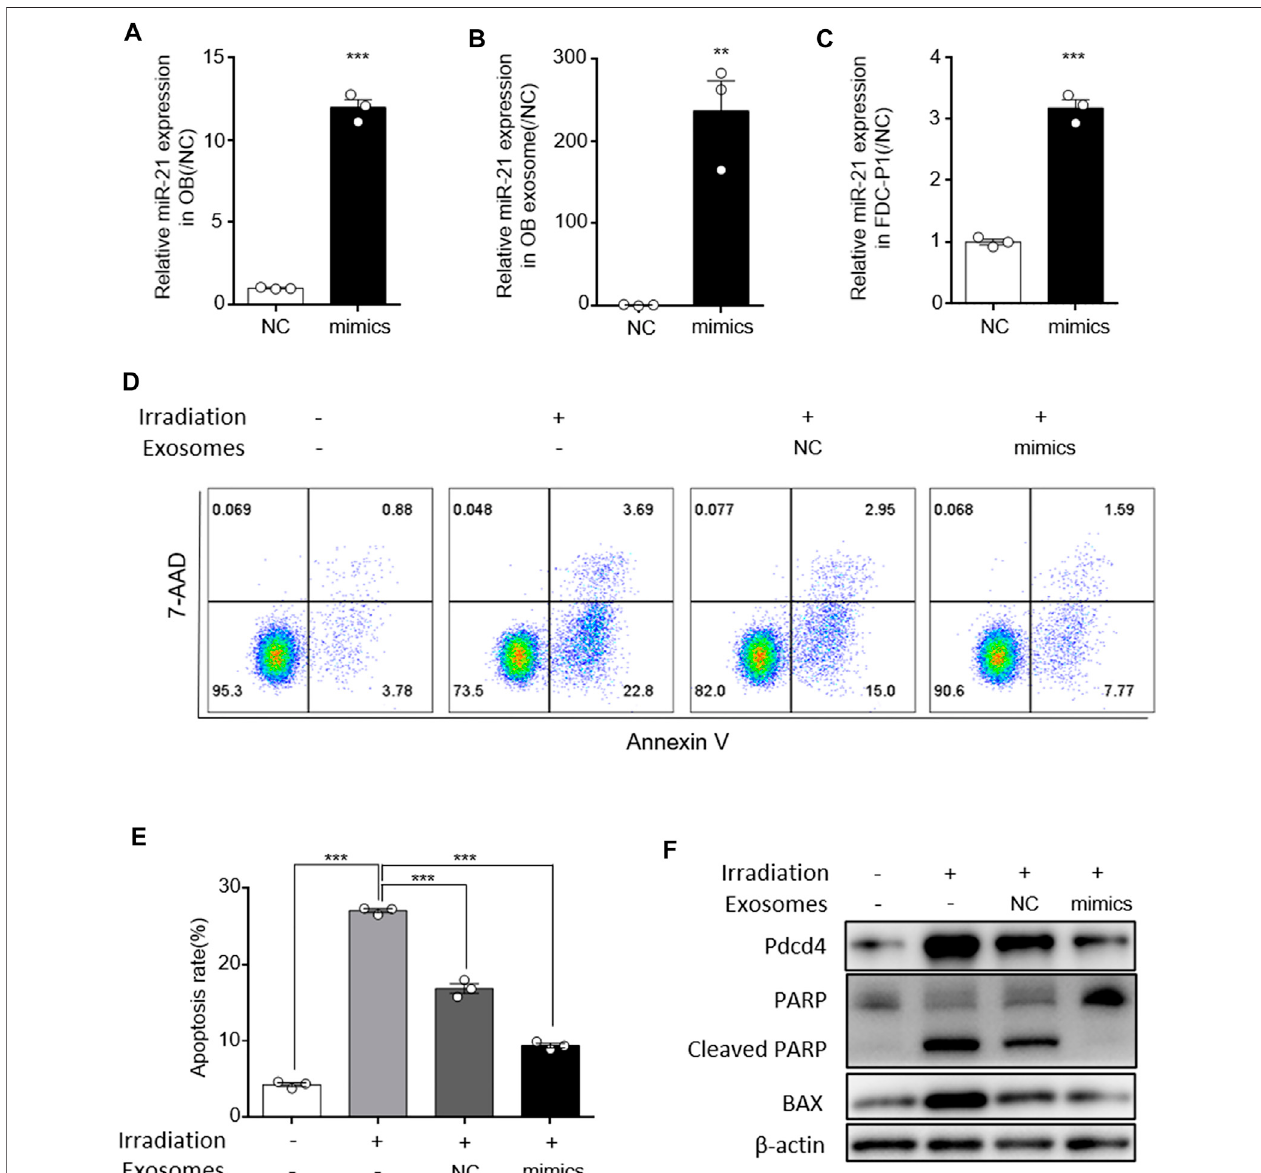
FIGURE 5 | MiR-21 in osteoblast derived exosomes alleviated irradiation induced FDC-P1 apoptosis. (A) qRT-PCR analysis of expression of miR-21 levels in osteoblast transfected with NC or miR-21 mimics. (B) qRT-PCR analysis of expression of miR-21 levels in OB-exosomes transfected with NC or miR-21 mimics. (C) qRT-PCR analysis of expression of miR-21 levels in FDC-P1 which were cocultured with OB-exosomes transfected with NC or miR-21 mimics. (D) FDC-P1 cells were irradiated with 2 Gy before co-cultured with OB-exosomes (NC/miR-21 mimics), and apoptosis was measured by fl ow cytometry. (E) Statistical analysis of the difference between control, irradiation and co-cultured with OB-exosomes (NC/miR-21 mimics) after irradiation groups. (mean ± sem, n = 3/group). (F) FDC-P1 cells were irradiated with 2 Gy before co-cultured with OB-exosomes (NC/miR-21 mimics), and protein levels of Cleaved PARP and BAX was measured by western blot.